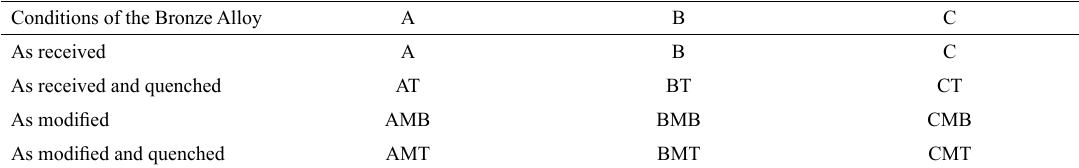
Table 3. Nomenclature used for bronze alloy modified during execution of the